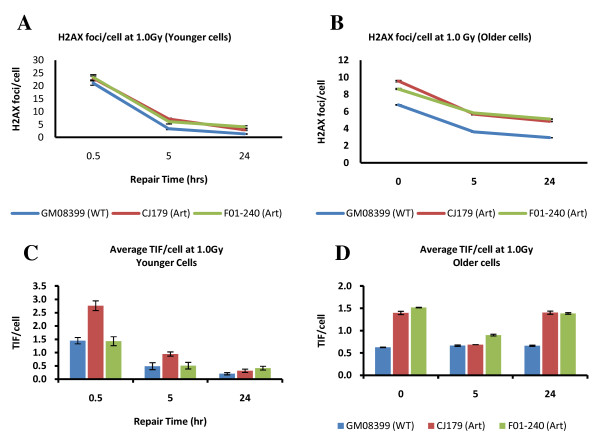
Repair kinetics of IR induced DNA damage. A and B. γ-H2AX foci per cell. C and D. TIFs per cell. Results are based on four independent experiments with on average 200 cell nuclei analysed per experiment per point. Error bars represent SEM. The dose of IR used was 1.0 Gy.